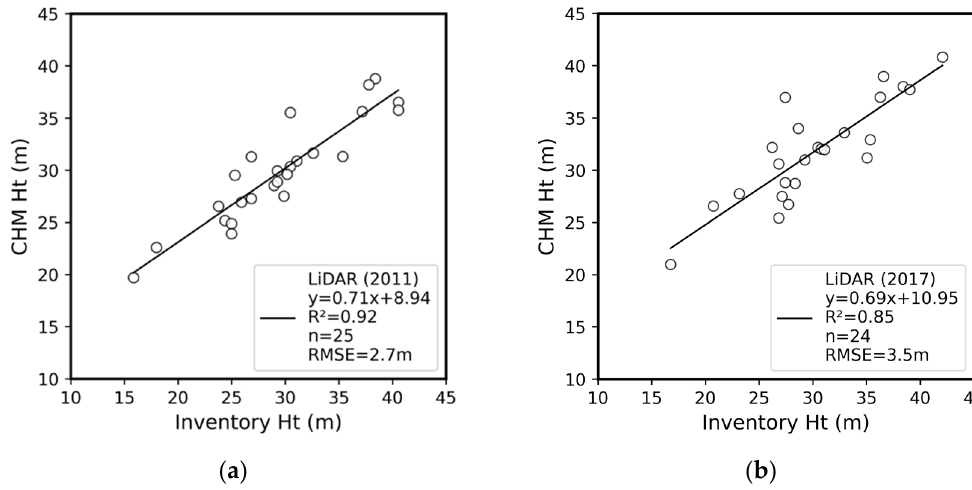
Figure 16. Agreement between inventory and canopy height when positional uncertainty was under approximately 0.1 m: ( a ) LiDAR measurement in 2011 and field measurement in 2009–2010, ( b ) LiDAR measurement in 2017 and field measurement in 2014–2015. CHM: canopy height model, Ht: height.